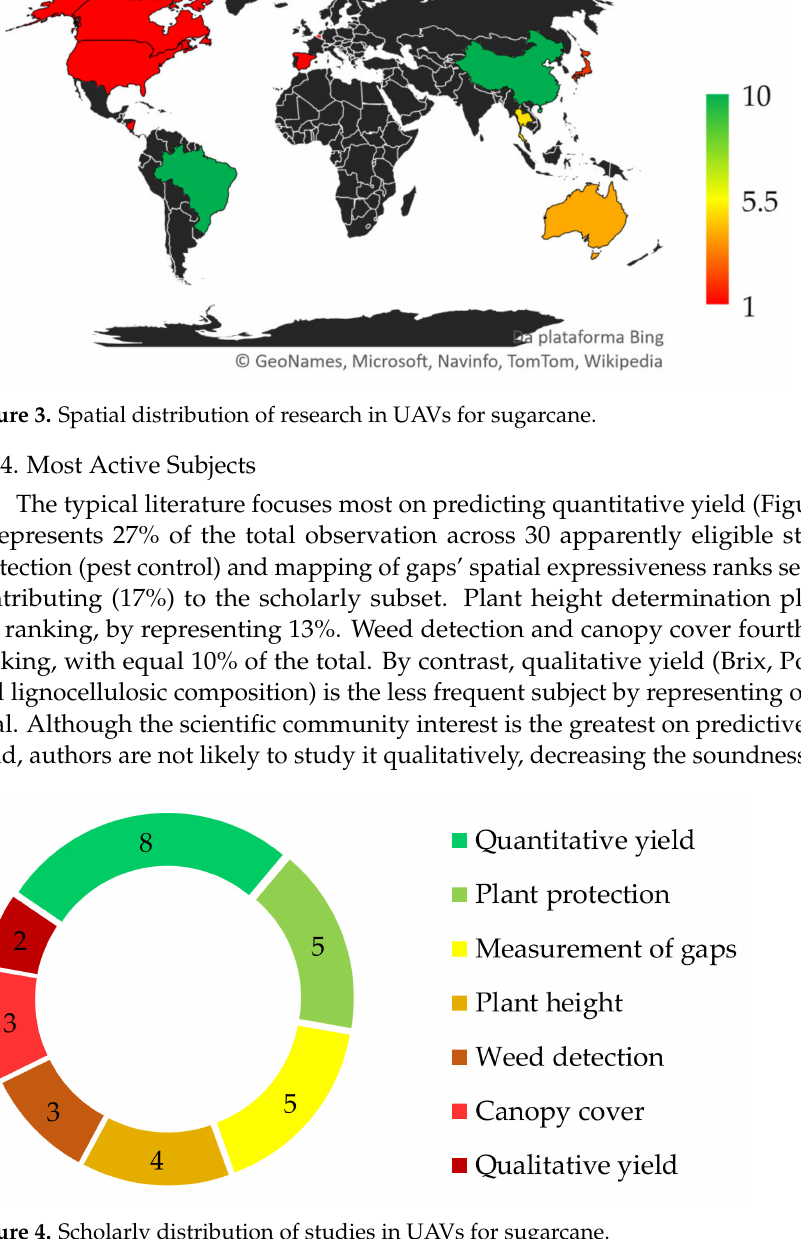
Figure 4. Scholarly distribution of studies in UAVs for